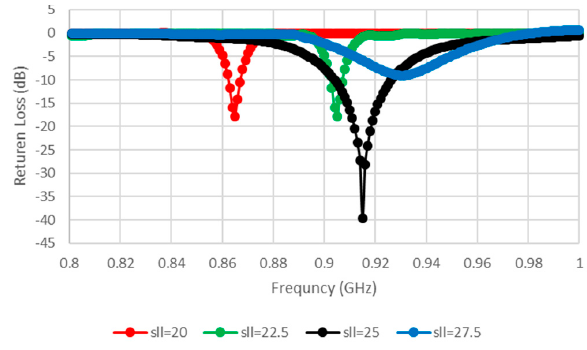
Figure 4. Simulated return loss (S11) for various slot lengths (sll).